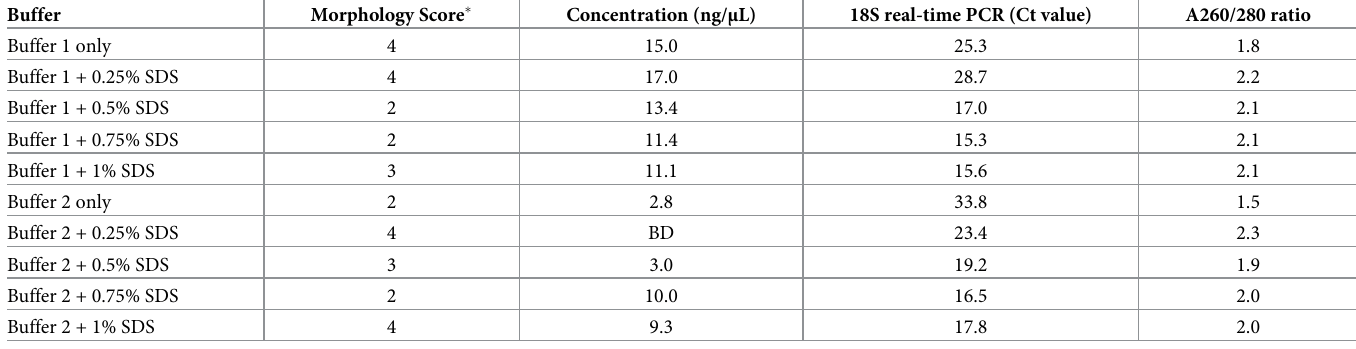
Table 2. Evaluation of Buffer 1 and Buffer 2 with 0 to 1% SDS lysis treatments of approx. 0.7 g dacini fruit flies on morphology and DNA extract purity and yield (BD = below detection; Ct = cycles above